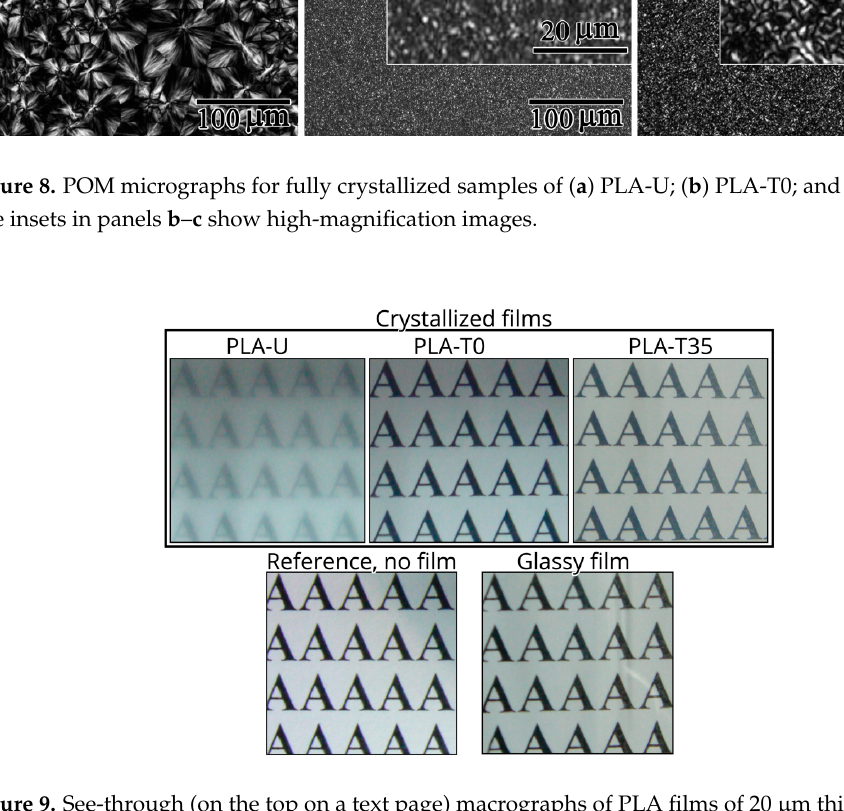
Figure 8. POM micrographs for fully crystallized samples of ( a ) PLA-U; ( b ) PLA-T0; and ( c ) PLA-T35. The insets in panels b – c show high-magnification images.